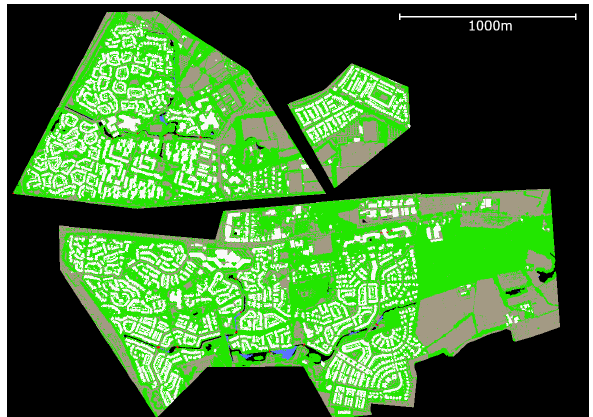
Figure 3. AHN3 point clouds used in this work. The upper left part shows the training set, the upper right part shows the valida- tion set and on the bottom is the testing area. Green: unassigned; brown-gray: ground; white: buildings; blue: water; red: bridges.